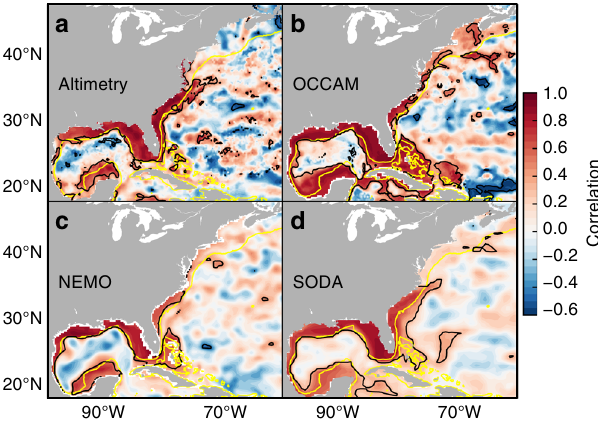
Fig. 4 Correlation maps from satellite altimetry and ocean models. Point- wise correlation between the amplitude of the SLAC at each grid point and that averaged along the United States Gulf and Southeast coasts for a altimetry (1993 – 2016), b OCCAM (1985 – 2003), c NEMO (1968 – 2012), and d SODA (1900 – 2010). The average has been computed over grid points within the 0 – 500 m depth range following the coast from Pensacola to Charleston. Black line denotes signi fi cance of the correlation at the 95% con fi dence level, whereas yellow line represents the 500 m